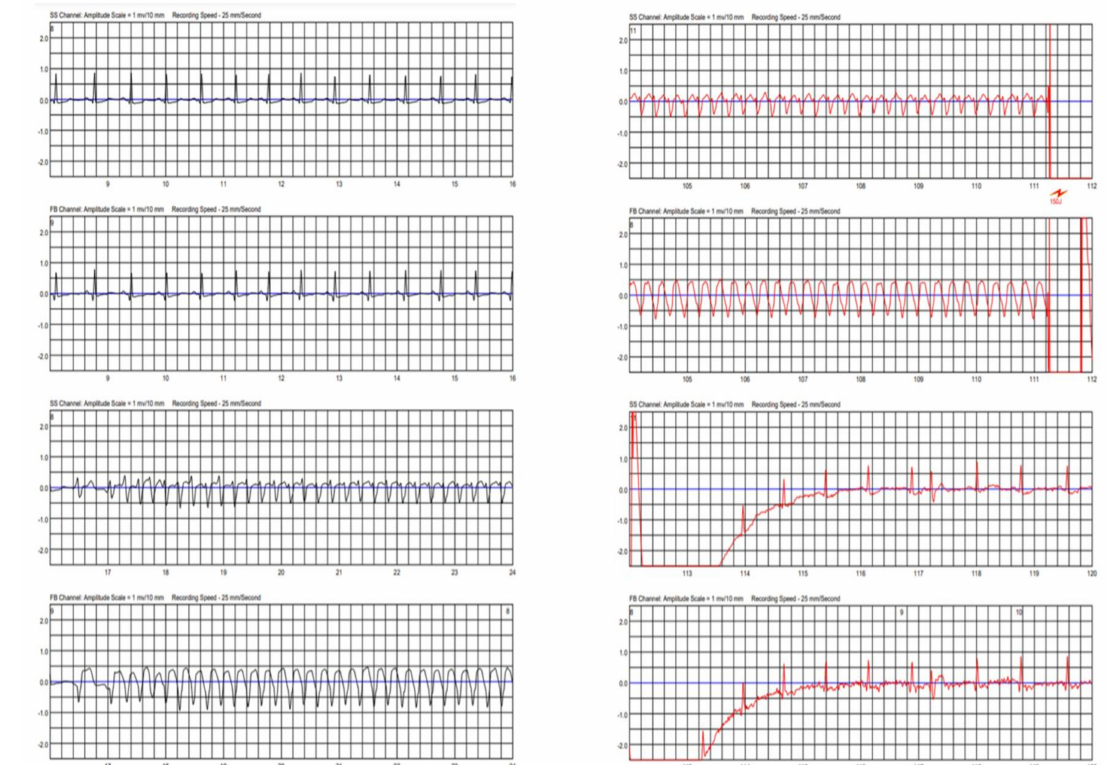
Figure 4. Two-lead recording from a wearable cardioverter-defibrillation (LifeVest) demonstrating a sustained monomorphic ventricular tachycardia event lasting for 94 s, which was ultimately terminated by a successful electrical shock, about 2 weeks after the index hospitalization. The figure illustrates the onset (time 17 s) and termination of the ventricular tachycardia event (time 111